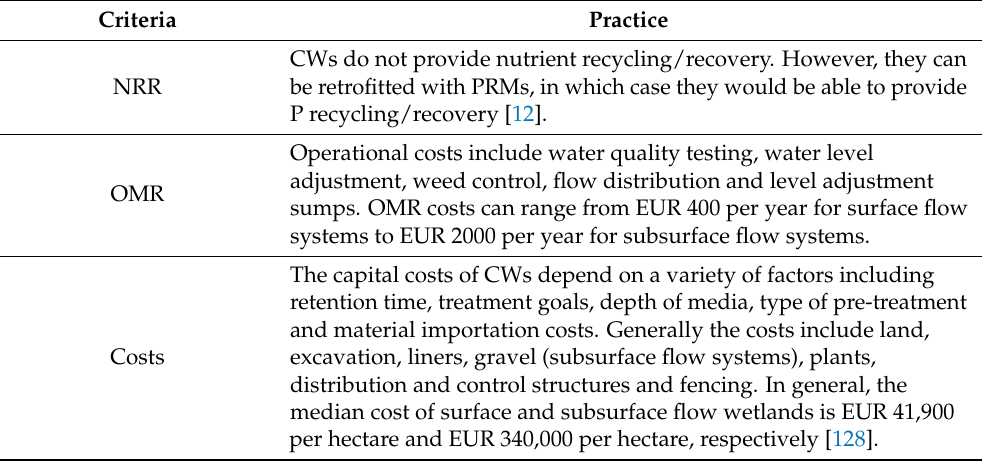
Table 4. Cont. Criteria Practice CWs do not provide nutrient recycling/recovery. However, they can NRR be retrofitted with PRMs, in which case they would be able to provide P recycling/recovery [12]. Operational costs include water quality testing, water level adjustment, weed control, flow distribution and level adjustment OMR sumps. OMR costs can range from EUR 400 per year for surface flow systems to EUR 2000 per year for subsurface flow systems. The capital costs of CWs depend on a variety of factors including retention time, treatment goals, depth of media, type of pre-treatment and material importation costs. Generally the costs include land, Costs excavation, liners, gravel (subsurface flow systems), plants, distribution and control structures and fencing. In general, the median cost of surface and subsurface flow wetlands is EUR 41,900 per hectare and EUR 340,000 per hectare, respectively